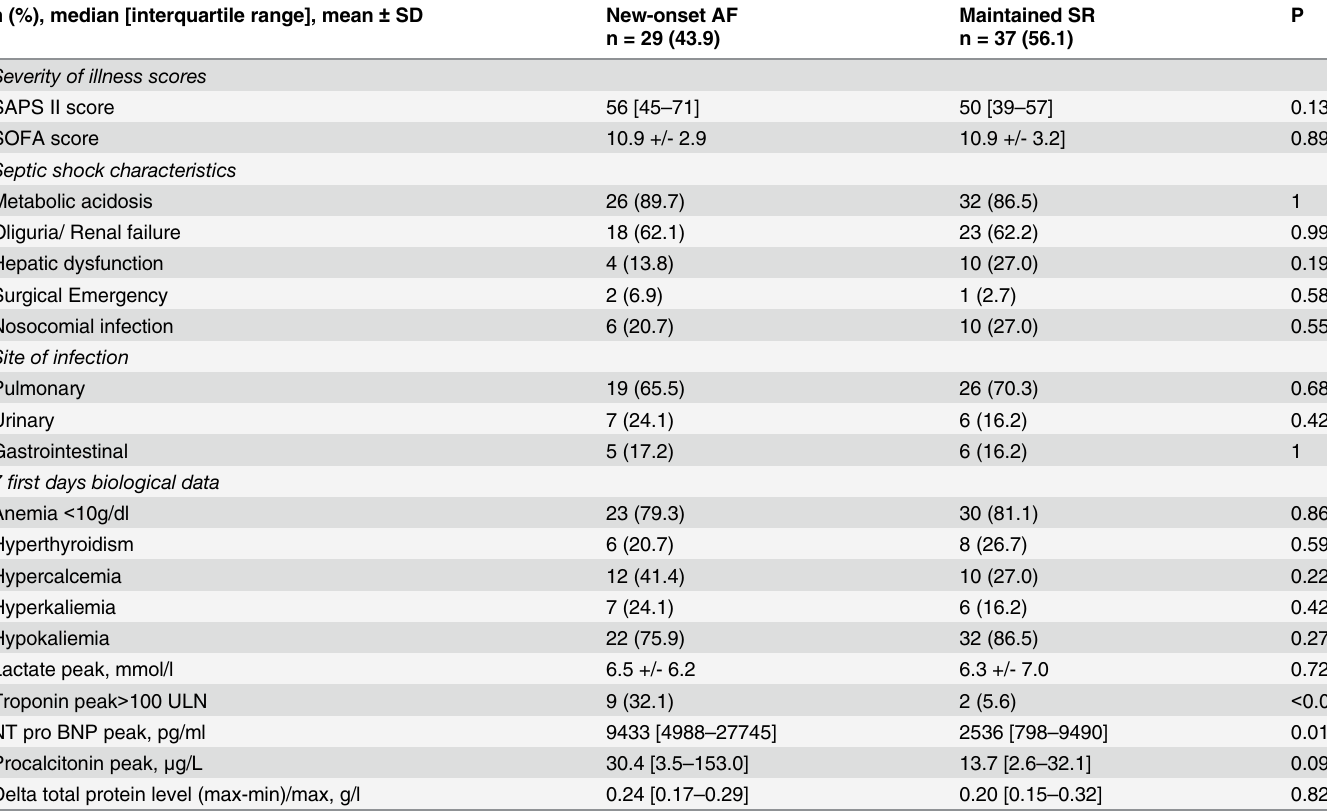
Table 2. Clinical and Biological Characteristics According To The Onset Of Atrial